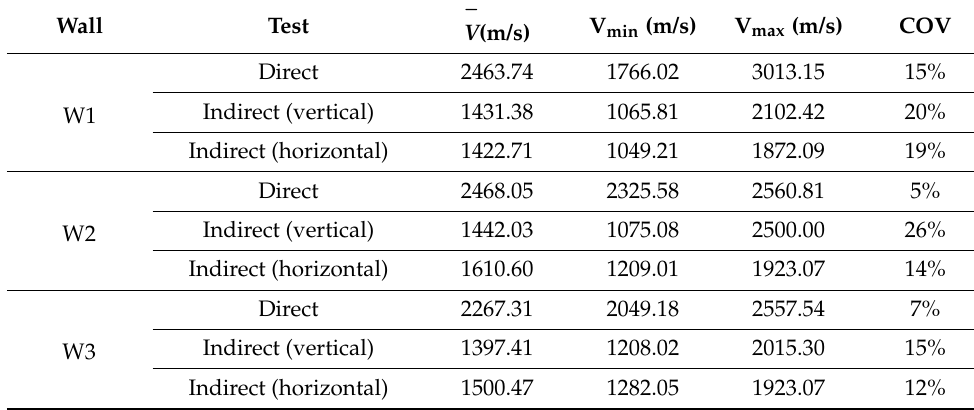
Table 1. Velocity values for the direct and indirect sonic